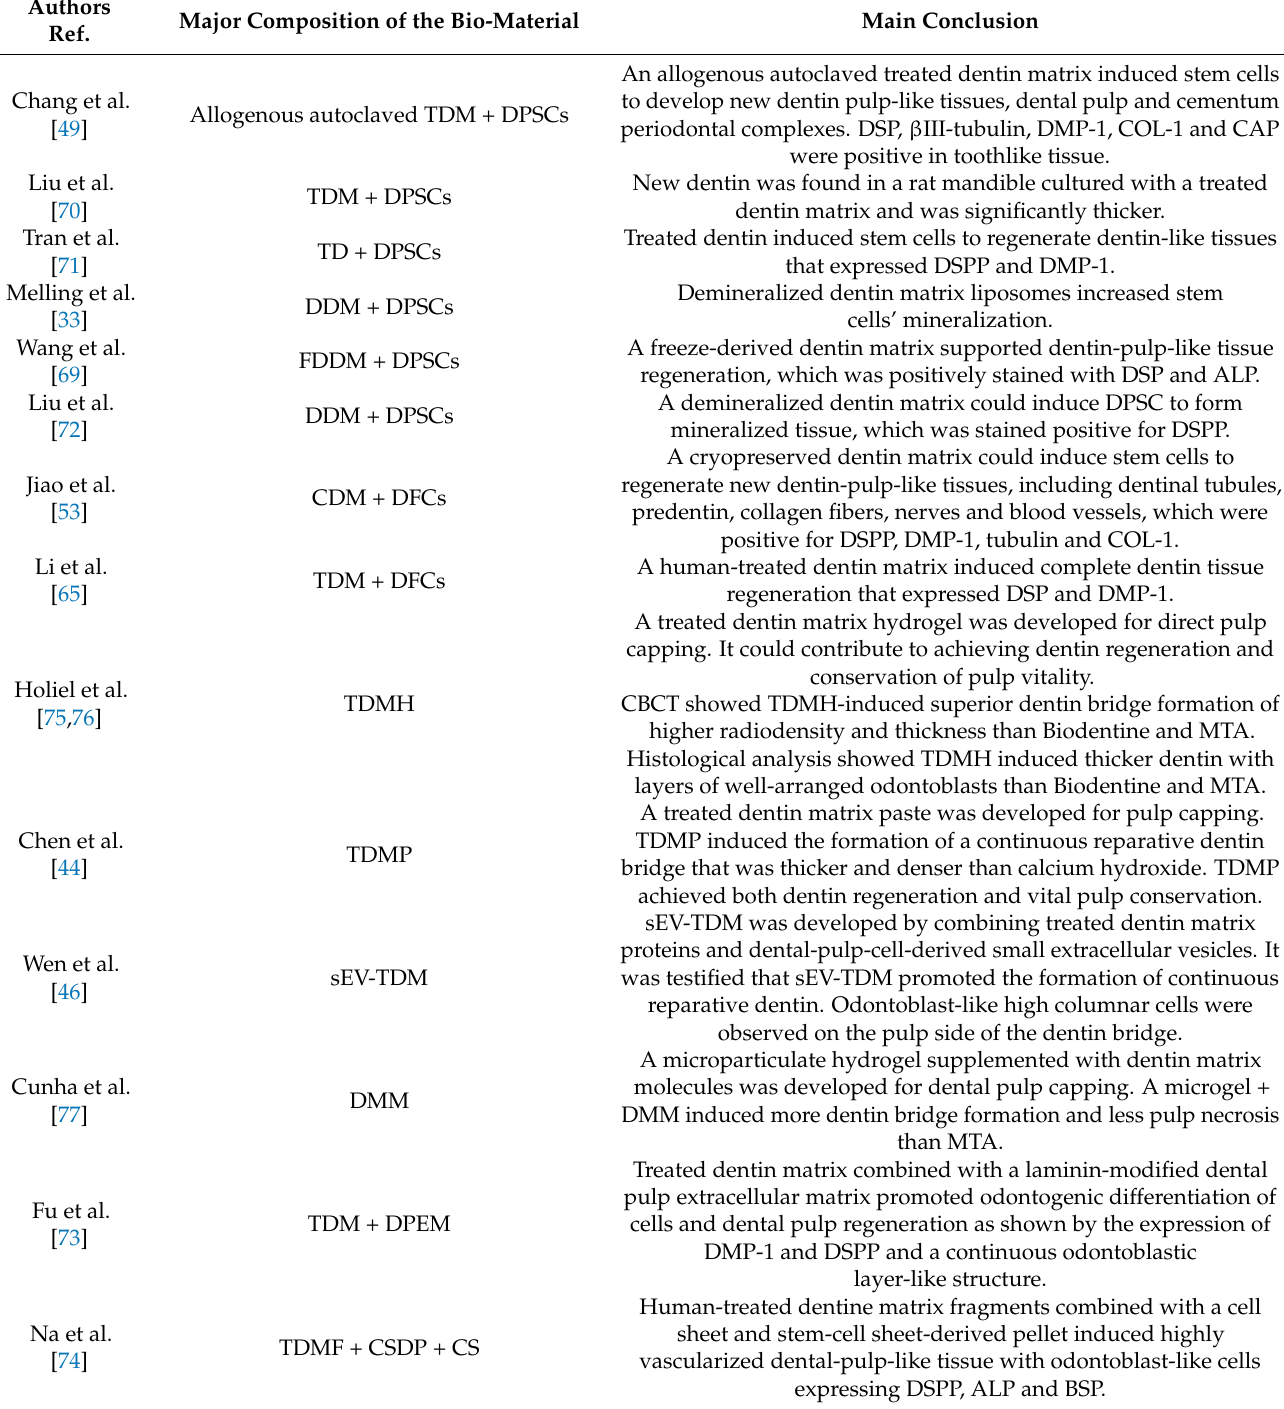
Table 4. Treated dentin matrix and its derivatives for dentin/pulp/dentin–pulp